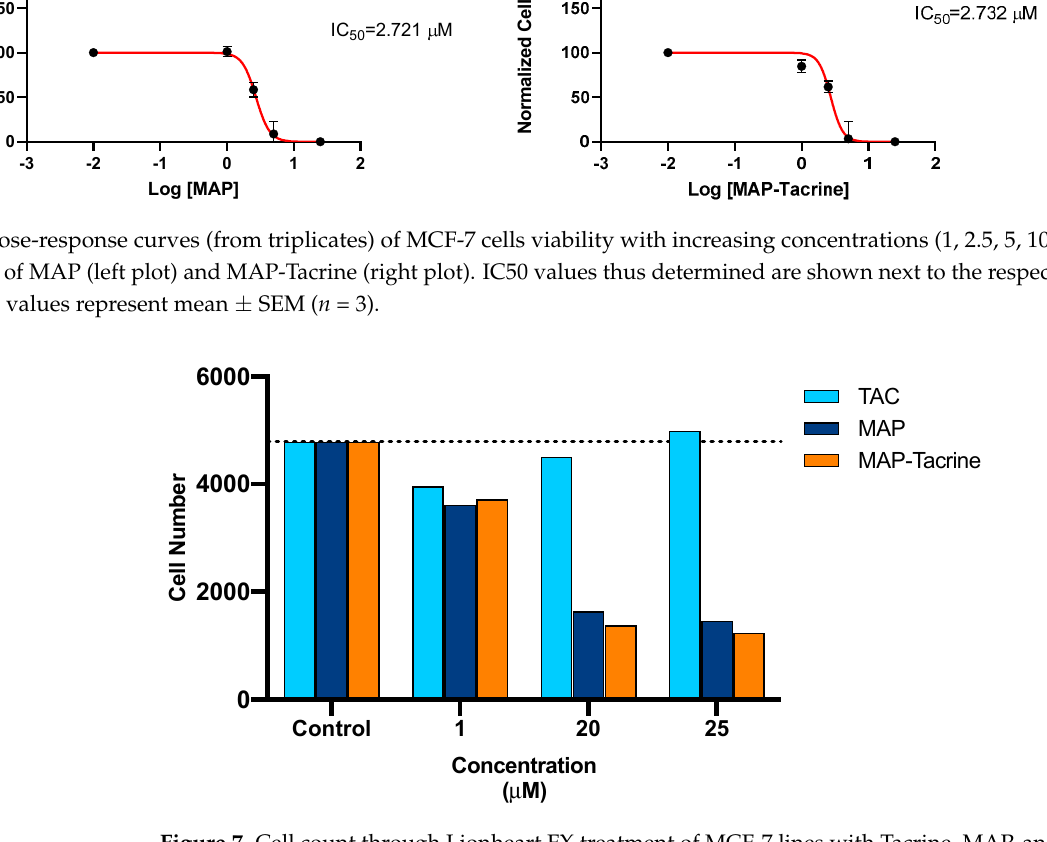
Figure 7. Cell count through Lionheart FX treatment of MCF-7 lines with Tacrine, MAP, and Tacrine-MAP (1, 20, and 25 µM) after 24 h incubation ( n = 1).